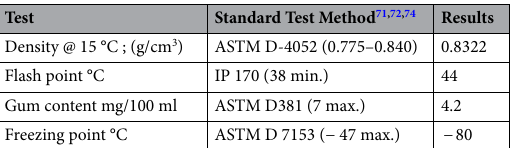
Table 8. Physical and Chemical Properties of Biofuels in Jet Fraction (150–270